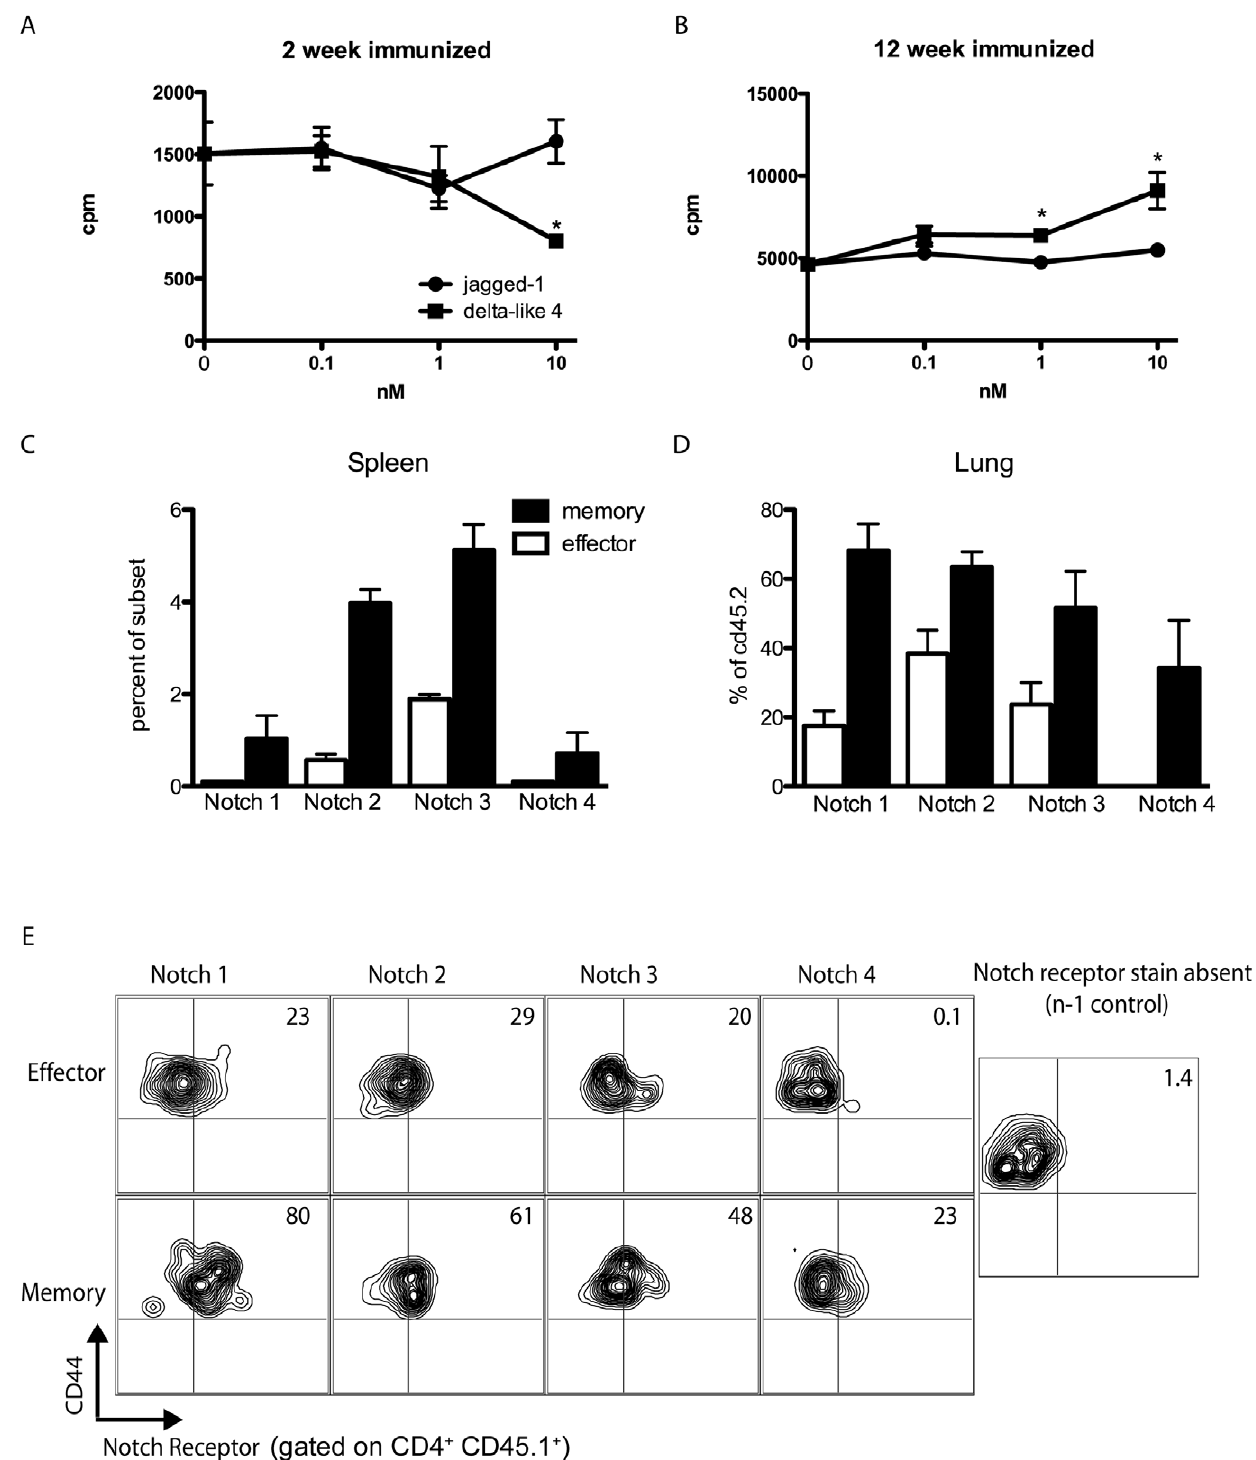
Figure 1. Memory and effector cells have different Notch related responses and express different levels of Notch receptors. A,B) Splenocytes from a mouse either 2 weeks or 12 weeks post S. Mansoni egg immunization were restimulated in vitro with SEA and increasing concentrations of delta-like 4 or jagged-1. *p , 0.05 C) Percent of endogenous memory or effector cells in the spleens of mice immunized for 6 weeks with S. Mansoni eggs. All cells expressing memory cell markers expressed a higher level of Notch receptor than those cells expressing effector cell markers (p , 0.05) D) Percent of donor (CD45.2) population expressing Notch receptors after incubation in a congenic sensitized mouse receiving S. Mansoni egg challenge. In all cases, the percentage of donor derived cells from those mice receiving memory cell transfer expressing a given Notch receptor were significantly higher than donor derived cells from mice receiving effector cell transfer. (p , 0.05) E) Flow plots gated on either effector or memory donor (CD45.1 + ) cells at day 9 of the secondary S. Mansoni egg model.